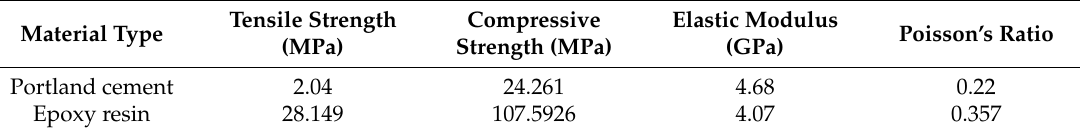
Table 1. Mixture components’ mechanical